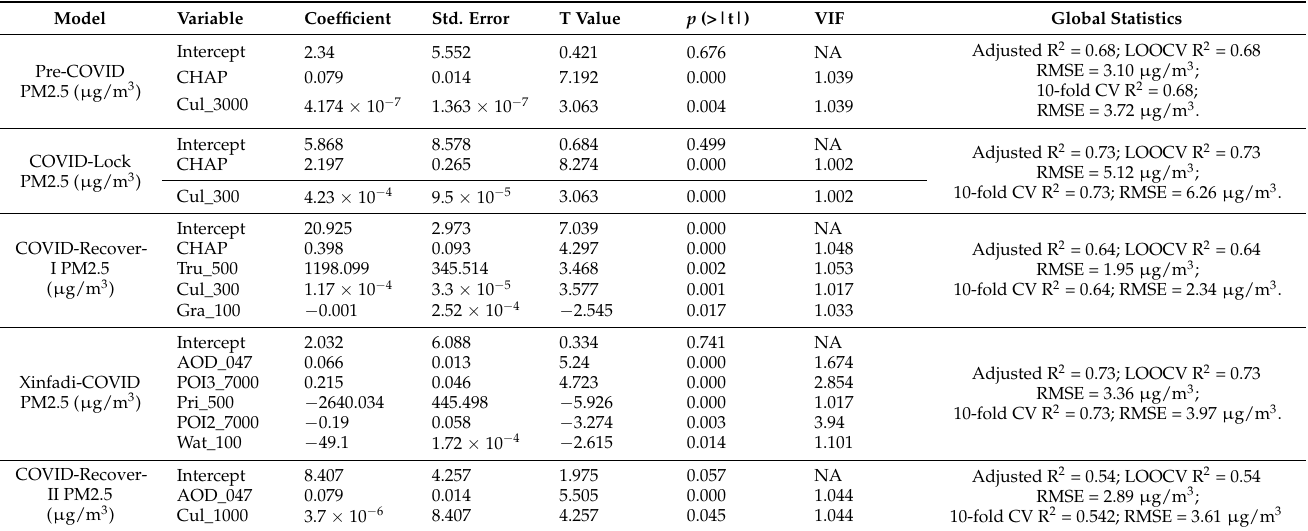
Table 3. Summary of the final LUR models for PM2.5 in P1–P5.